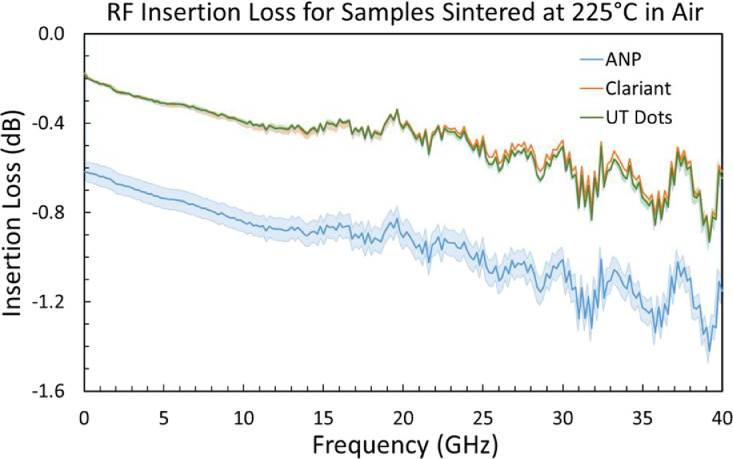
Example of average S21 (insertion loss) spectra for co-planar waveguides printed using each of the three inks and sintered at 225°C. Shaded regions represent the standard deviation for five CPWs per sample.